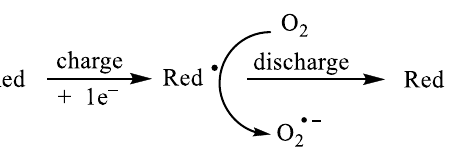
Figure 5. Schematic representation of the reaction between the anolyte and the oxygen.